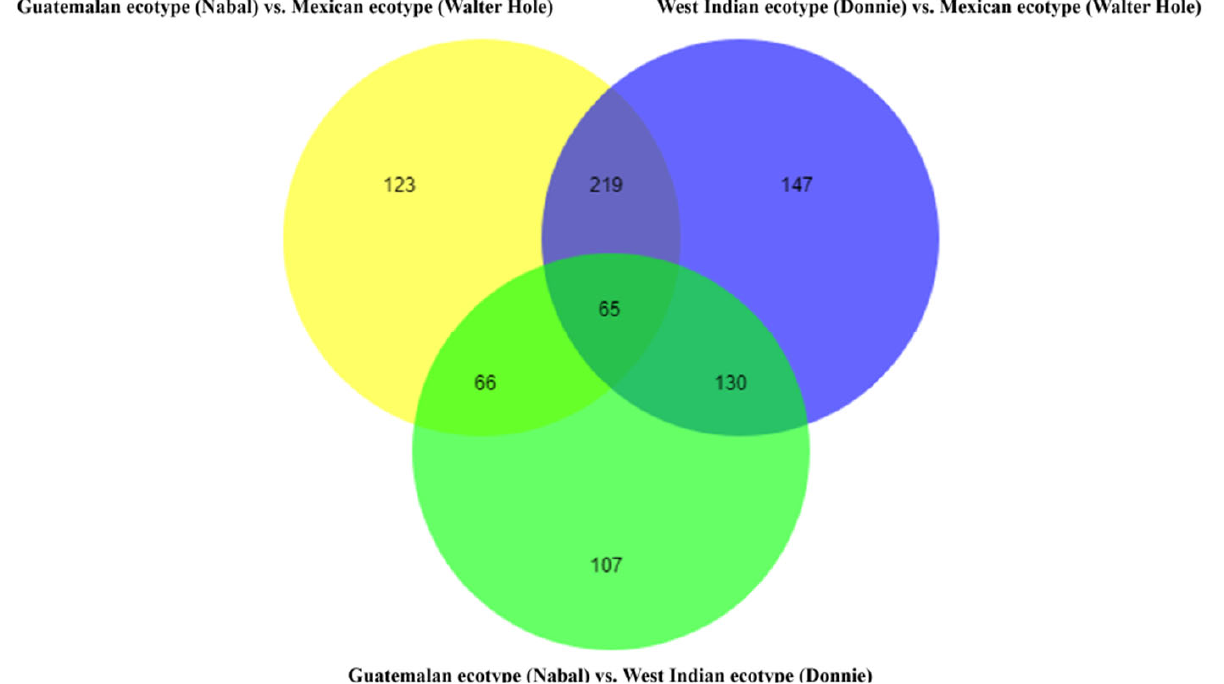
Figure 4. Detection of 857 differentially accumulated lipids in the mature avocado mesocarps of three ecotypes. Significant differences in the relative contents of 473, 561, and 368 lipids were revealed in the Guatemalan ecotype (Nabal) vs. Mexican ecotype (Walter Hole), the West Indian ecotype (Donnie) vs. Mexican ecotype (Walter Hole), and the Guatemalan ecotype (Nabal) vs. West Indian ecotype (Donnie) comparisons, respectively (Table S4). In these pairwise comparisons, the dominating class with differentially accumulated lipids was always TAGs (Figure 5). The lipids with relative contents that differed by a factor of 10,000 between ecotypes were identified as TAG 16:0-17:1-18:1 and TAG 17:1-18:1-19:2 (TAG) (Guatemalan ecotype (Nabal) vs. Mexican ecotype (Walter Hole)), as well as (West Indian ecotype (Donnie) vs. Mexican ecotype (Walter Hole)). The fold-changes in the relative contents of differentially accumulated lipids were substantially lower for the Guatemalan ecotype (Na- bal) vs. West Indian ecotype (Donnie) comparison than for the other pairwise comparisons, with the minimal fold-change (7753) detected for TAG 14:1-14:1-18:5 (TAG) (Table